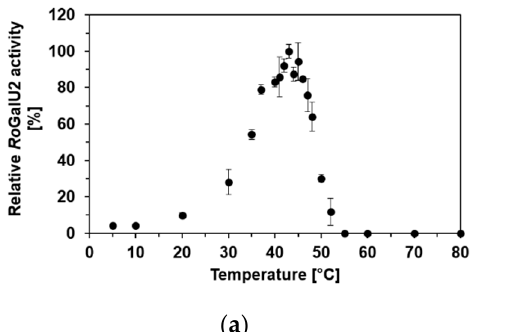
Figure 6. Temperature-dependent activity ( a ) and stability ( b ) of purified Ro GalU2 enzyme was measured in triplicates. Activity was measured with pre-incubation of the assay mixture (2 mM UTP, 2 mM glucose 1-phosphate, 4 mM MgCl 2 , 50 mM Hepes buffer, pH 7.0, 30 µg Ro GalU2, 1 mL reaction volume) at indicated temperatures. The enzyme was stored on ice and directly used for measurements. For stability measurements the enzyme was incubated shaking for 30 min at indicated temperatures and directly used for activity assay at 45 °C. Means and standard deviations are shown. 100% relative Ro GalU2 activity correspond to 6.7 U mg − 1 (( a ), activity) and 5.0 U mg − 1 (( b ), stability), respectively.